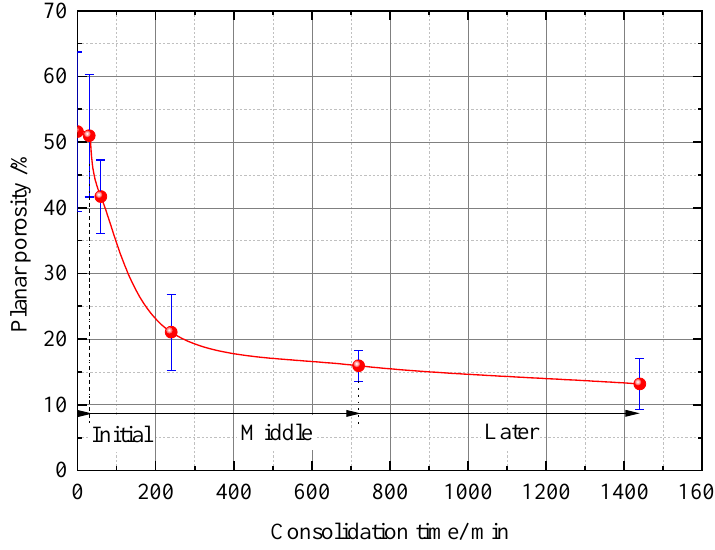
Figure 7. The curve of plane porosity under different consolidation times.